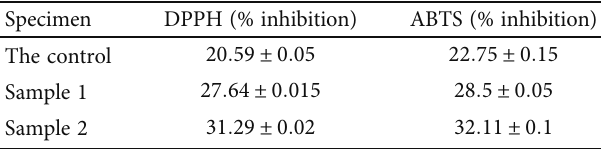
Table 5: Antioxidant activity in terms of DPPH and ABTS. Specimen